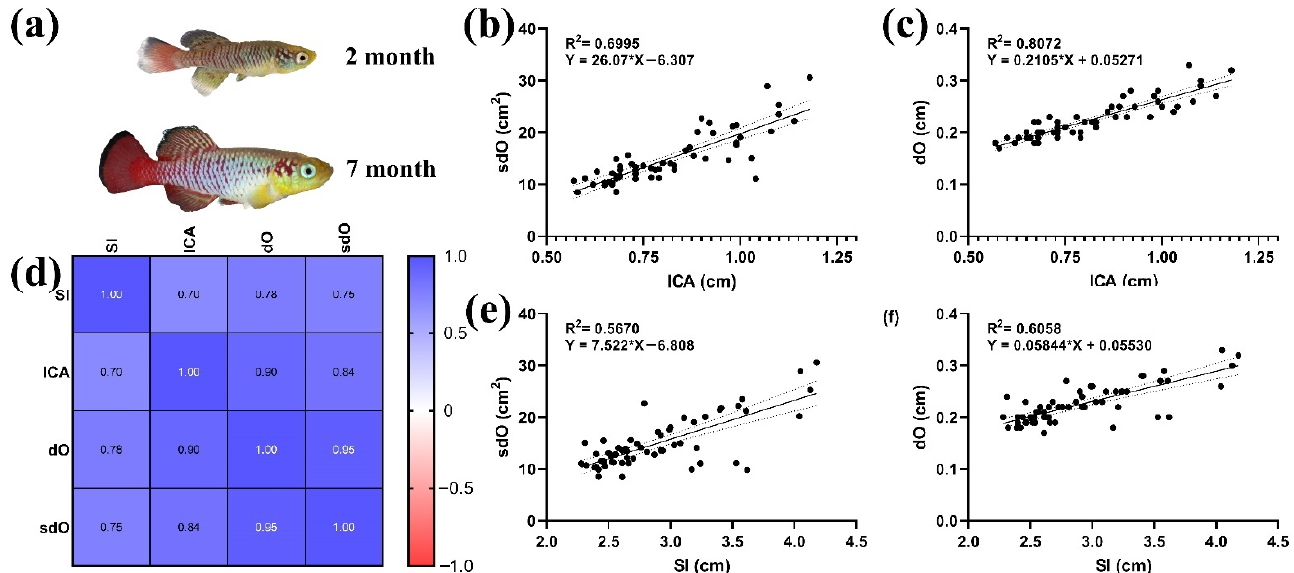
Figure 5. Morphoanatomical parameters of N. guentheri adults: ( a ) N. guentheri of different ages, two and seven months; ( b ) linear regression ICA and sdO; ( c ) linear regression ICA and dO; ( d ) correlation matrix of morphometric parameters; ( e ) SI and sdO linear regression; ( f ) SI and dO linear regression.